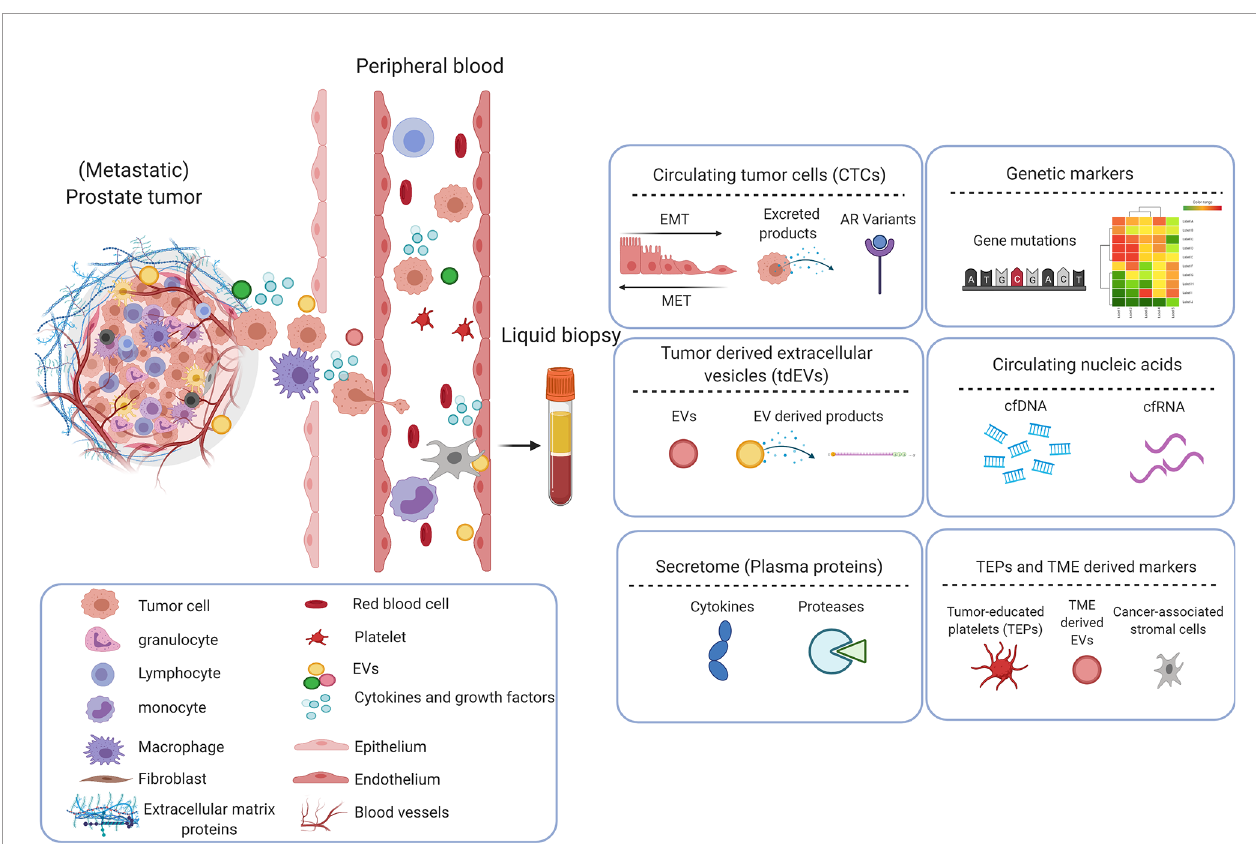
FIGURE 2 | Circulating biomarkers in prostate cancer. Primary prostate cancer metastasizes when tumor cells and cellular components break away and enter circulation (vasculature or lymphatics), travel to distant sites and form secondary tumor(s). These circulating tumor components provide an insight into the phenotypic and genotypic properties of the tumor, can act as a prognostic and predictive tool in determining the outcome of treatments. Circulating tumor cells (CTCs), extracellular vesicles (EVs), secretome (plasma proteins), genetic markers, circulating nucleic acids and other cells i.e., cancer-associated stromal cells or tumor- educated platelets (TEPs) in circulation, have been identi fi ed as potential biomarkers and is explored to further understand the clinical progression of prostate cancer and to aid development/optimization of treatments. Created with